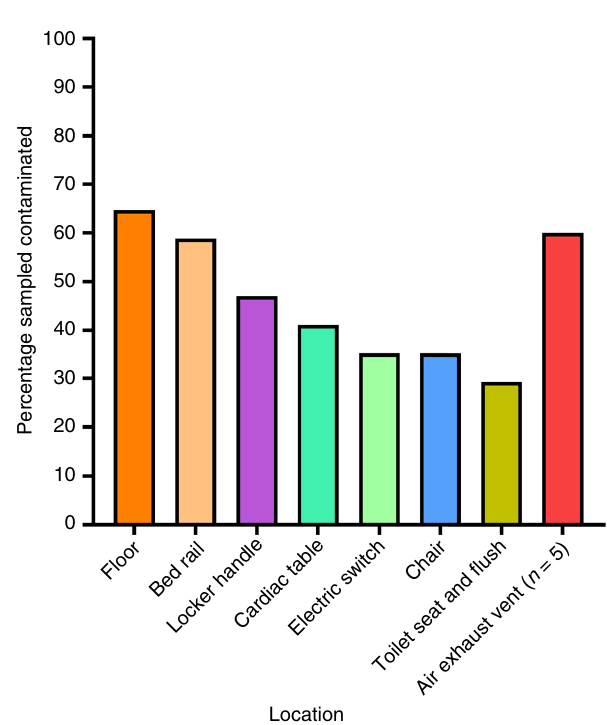
Fig. 1 Percentage of contaminated swabs from surface samples, in rooms with any contamination. All sites were n = 17, except for air exhaust vents where n = 5.